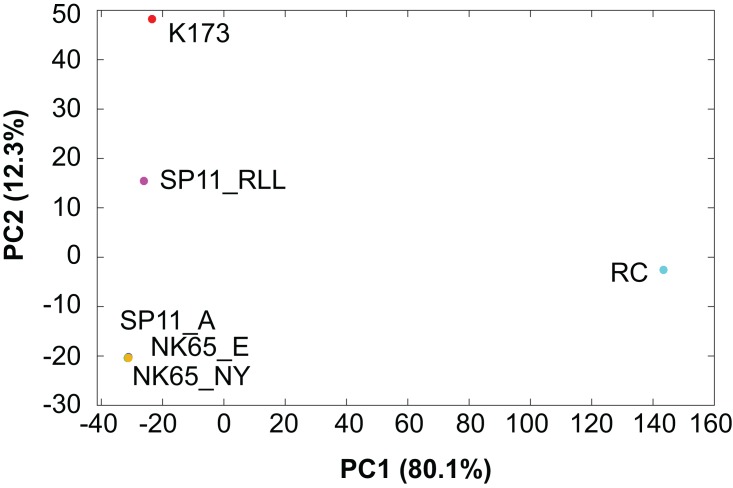
Principal components analysis of P. berghei strains.The genotypic data from 8,681 single nucleotide variants called from whole genome sequences were encoded as a matrix for principal components analysis. The loadings from the first and second principal components for each strain are plotted.